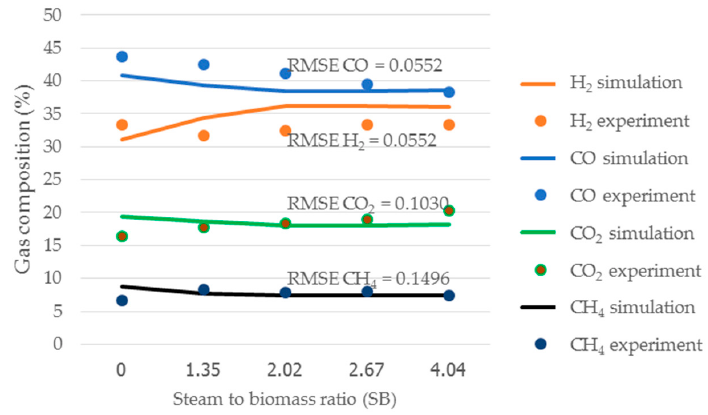
Figure 7. Experimental and simulation data comparison of gas composition with respect to steam-to-biomass ratio.